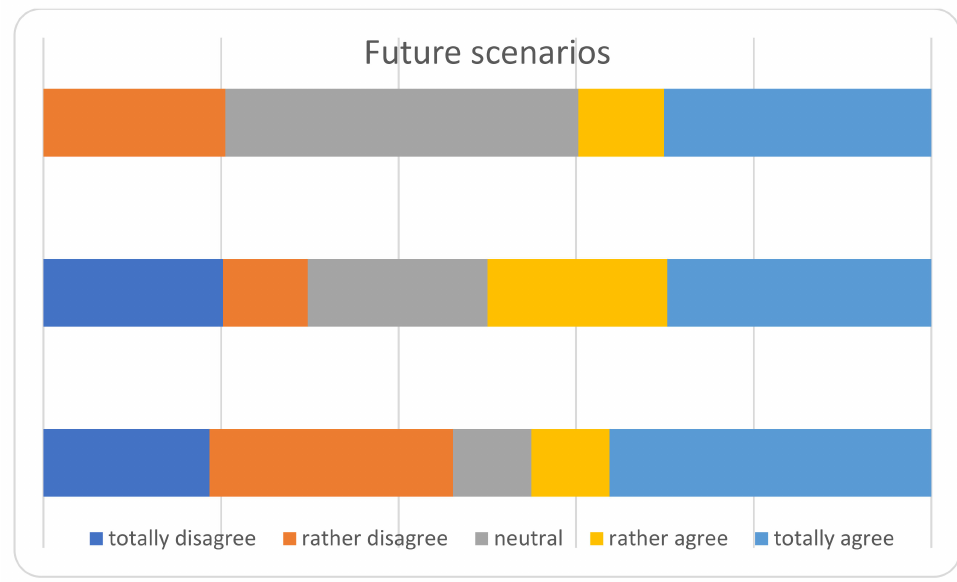
Figure 6. Future